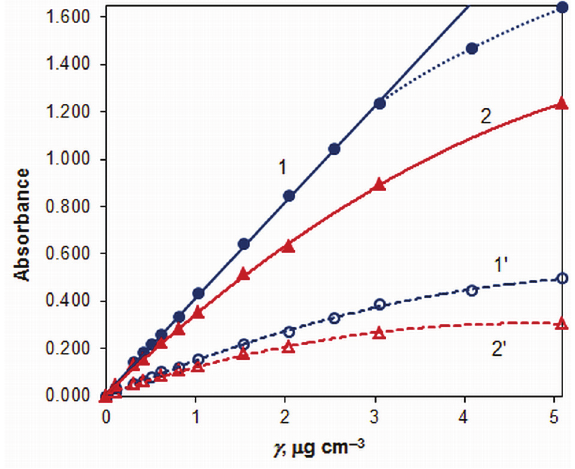
Figure 9: Absorbance of extracted species vs concentration of vanadium. pH 5.5, c = 1.0×10 −3 mol dm −3 , λ = 333 nm (1 and 2) TTC